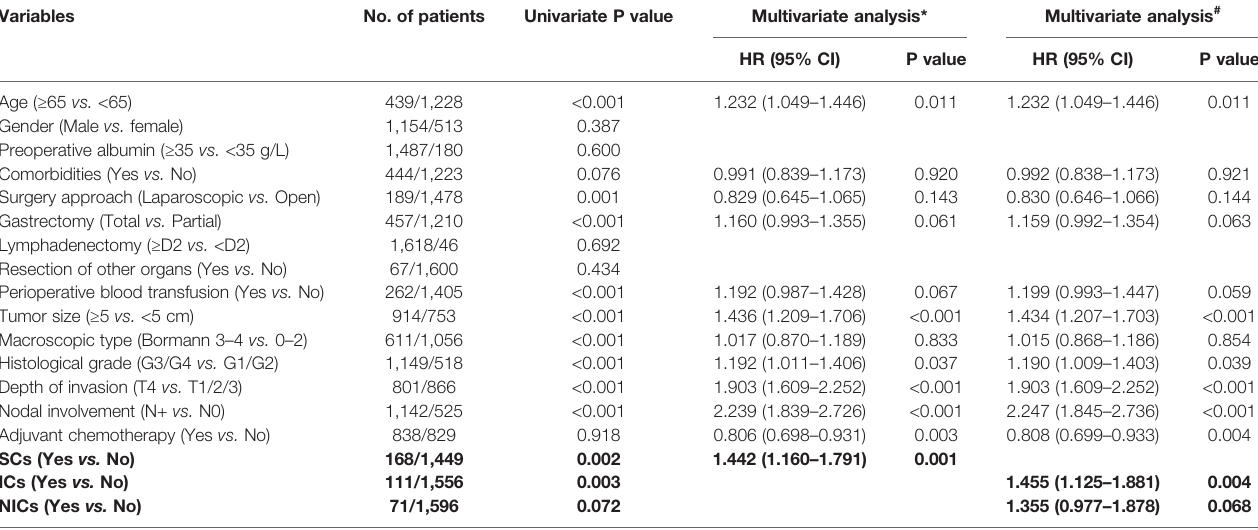
*Multivariate analysis describing the prognosis of SCs for gastric cancer patients. # Multivariate analysis describing the prognosis of ICs and NICs for gastric cancer patients. The bold values indicate the main objects of this